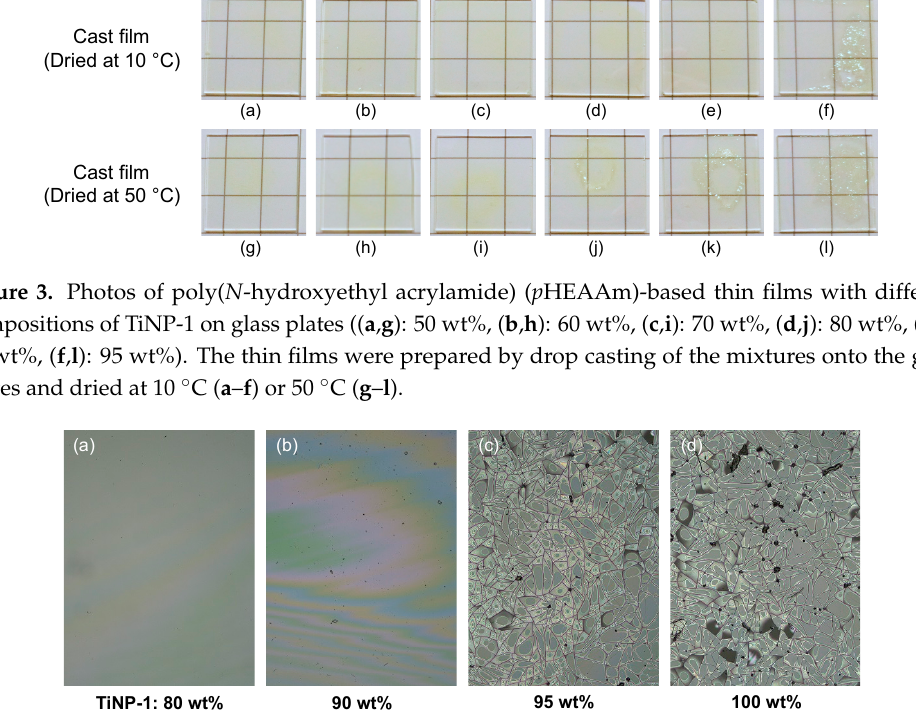
Figure 4. Laser microscopic images (120 × ) of the surfaces of TiNP-1/ p HEAAm composite films with different compositions. ( a ) TiNP-1: 80 wt%, ( b ) TiNP-1: 90 wt%, ( c ) TiNP-1: 95 wt%, ( d ) TiNP-1: 100 wt%. The composite films were prepared by casting at 10 °C.